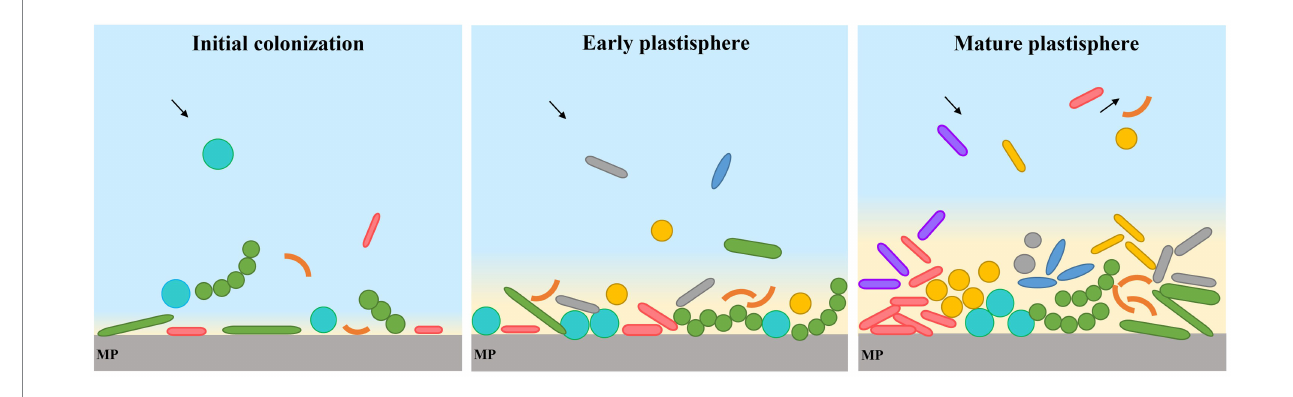
FIGURE 2 The formation of and succession in the